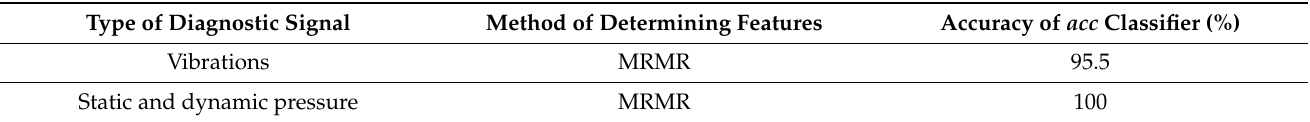
Table 7. Accuracy of pump status